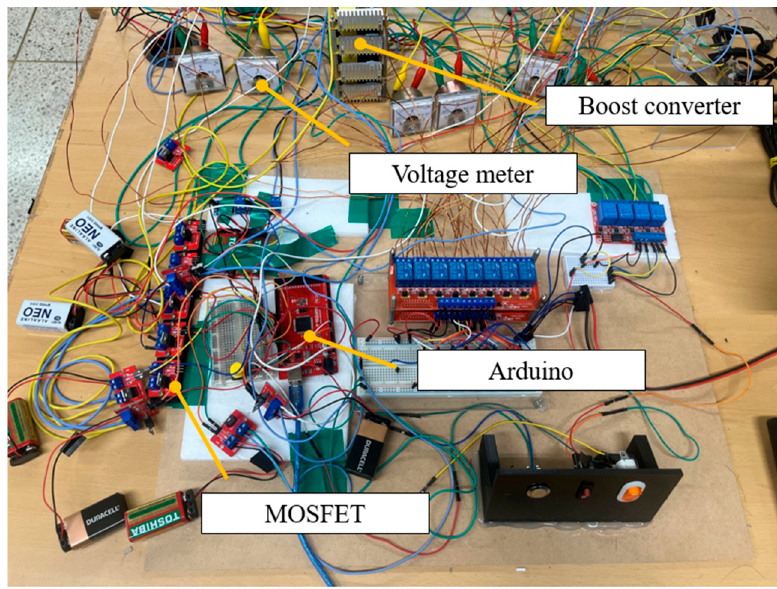
Figure 8. The nine-stage coil gun system’s charging-discharging circuit.